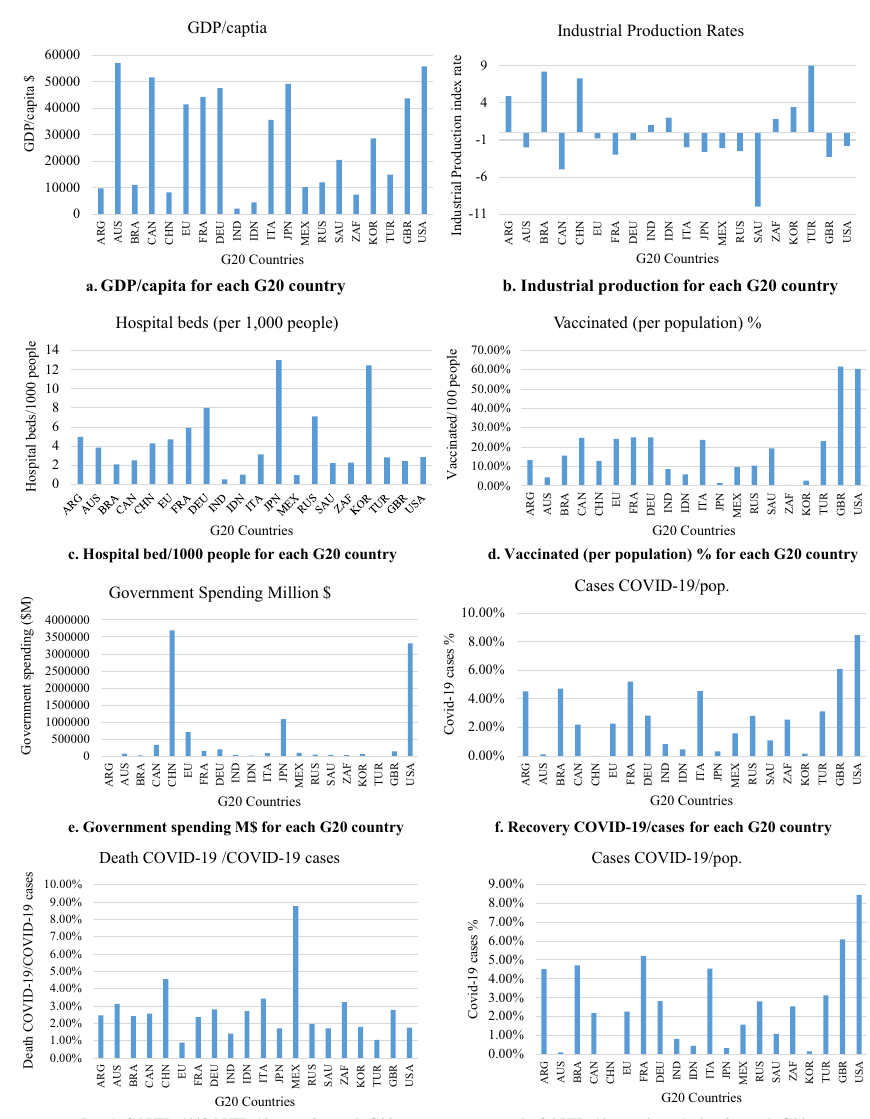
Fig. 1 a GDP/capita for each G20 country. b Industrial production for each G20 country. c Hospital bed/1000 people for each G20 country. d. Vaccinated (per population) % for each G20 country. e Government spending M$ for each G20 country. f Recovery COVID-19/cases for each G20 country. g Death COVID-19/COVID-19 cases for each G20 country. h COVID-19 cases/population for each G20